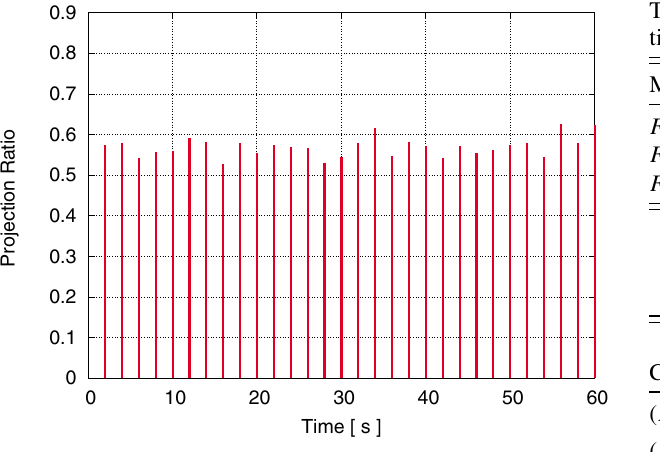
FIG. 5. (Color) Example of projection ratio continuous measure- ment.